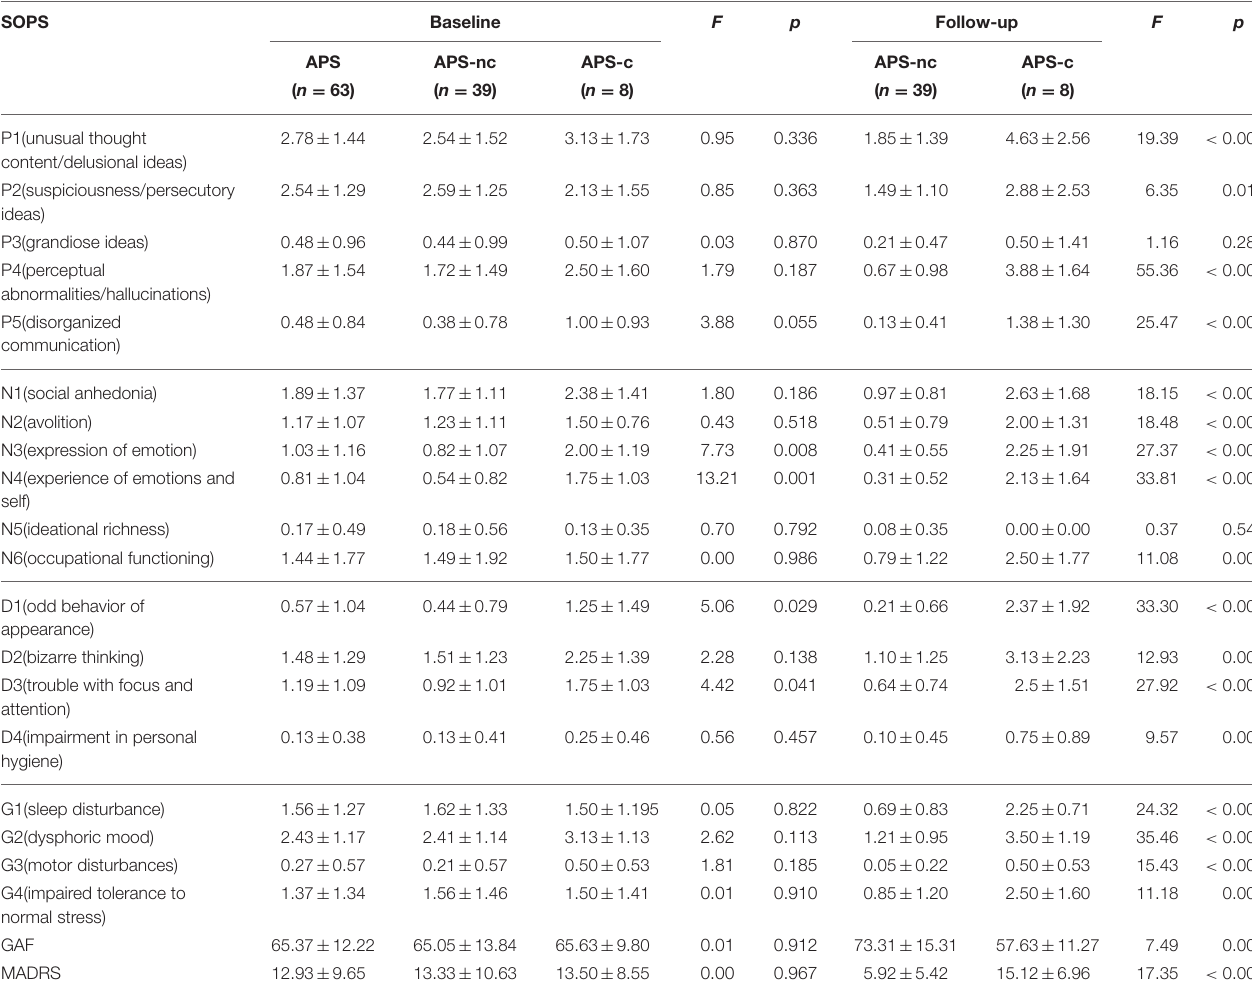
TABLE 1 | Description of attenuated symptoms and related clinical manifestations at baseline and 6-month follow-up interval (Mean ± SD)